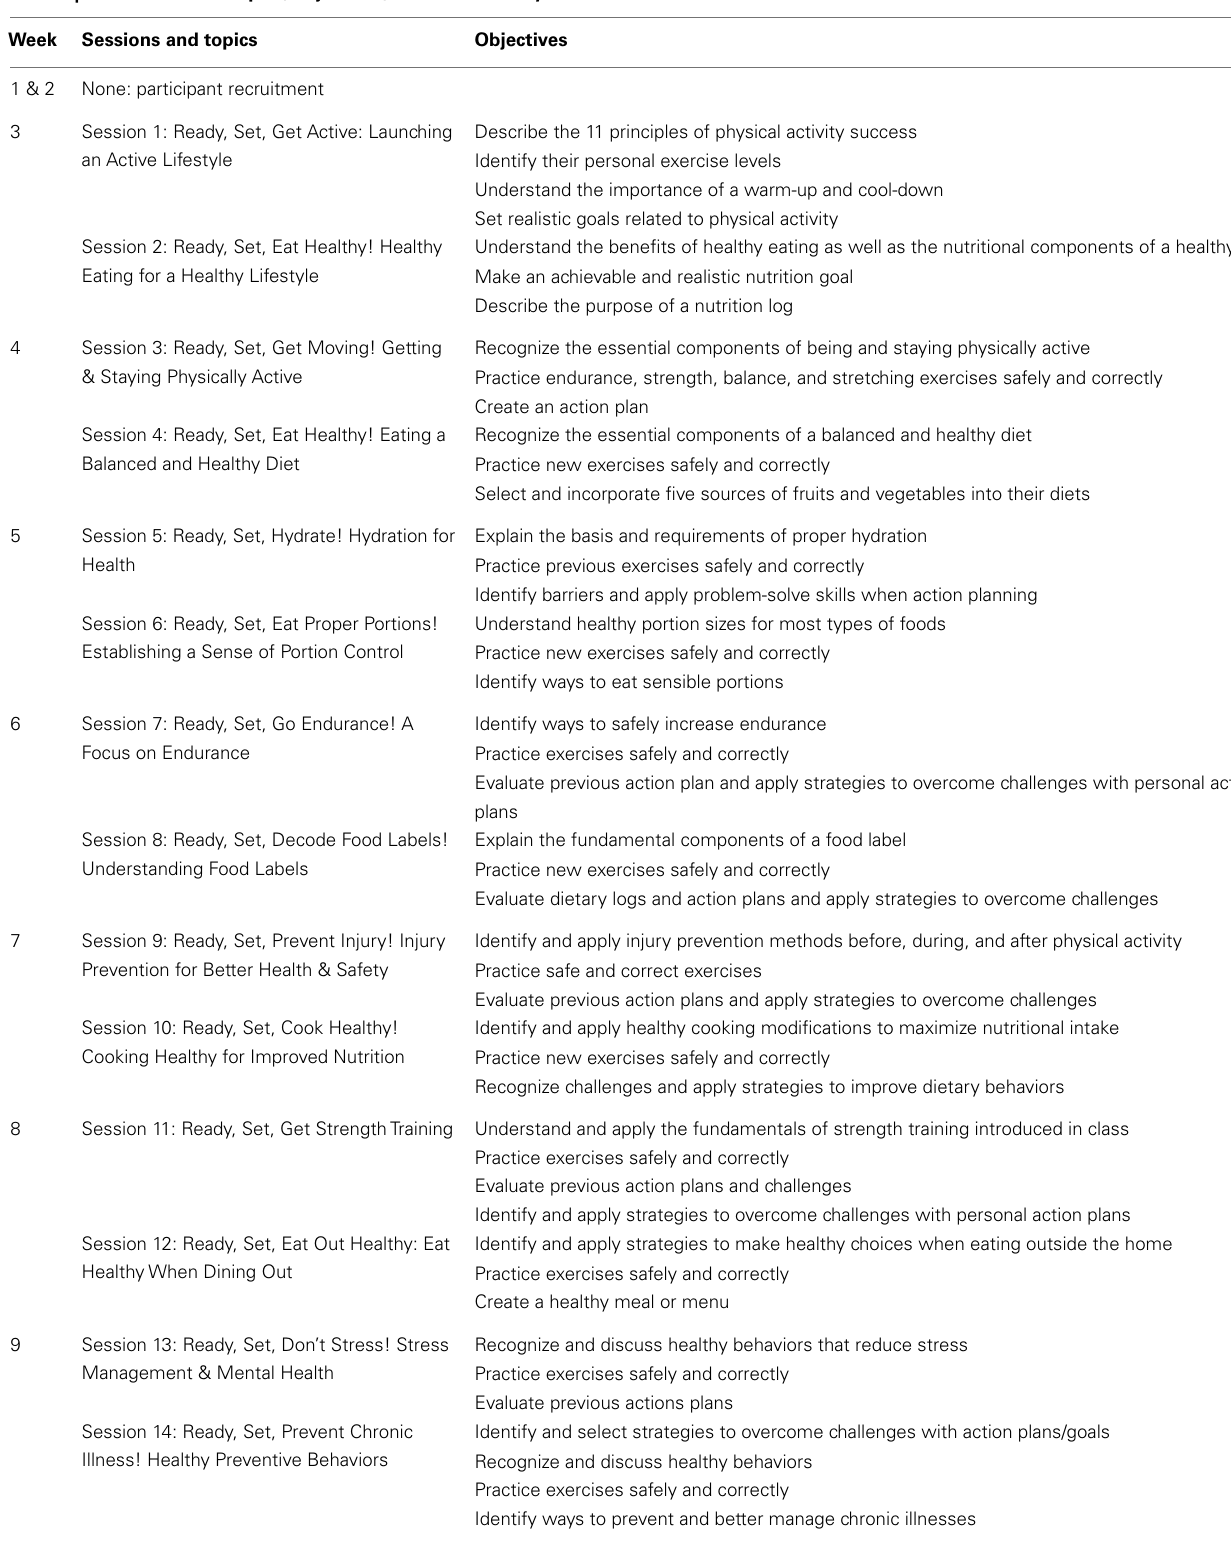
Table 1 |Texercise Select topics, objectives, and resources by week . Week Sessions and